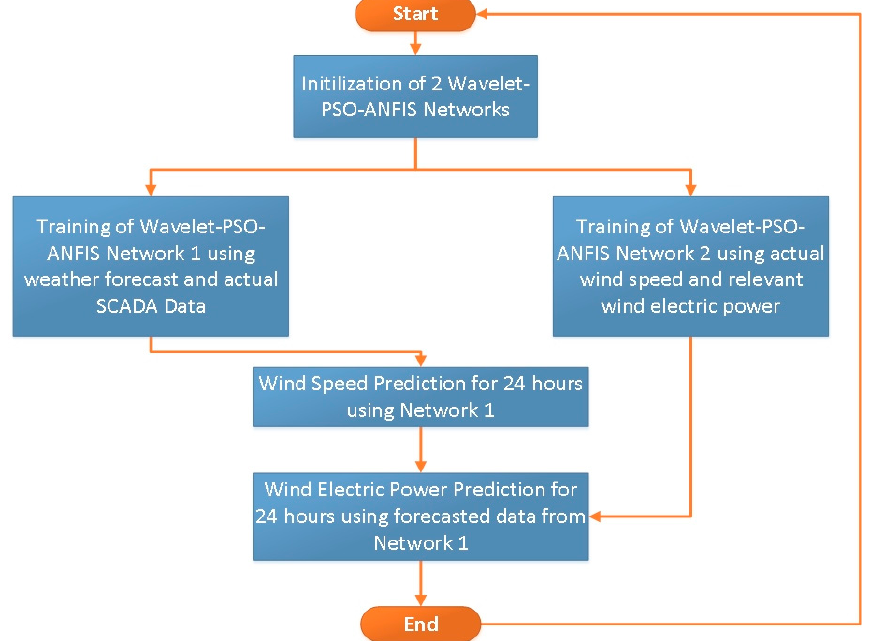
Figure 4 . Proposed Double Staged Wavelet-PSO-ANFIS Flowchart. Figure 4. Proposed Double Staged Wavelet-PSO-ANFIS